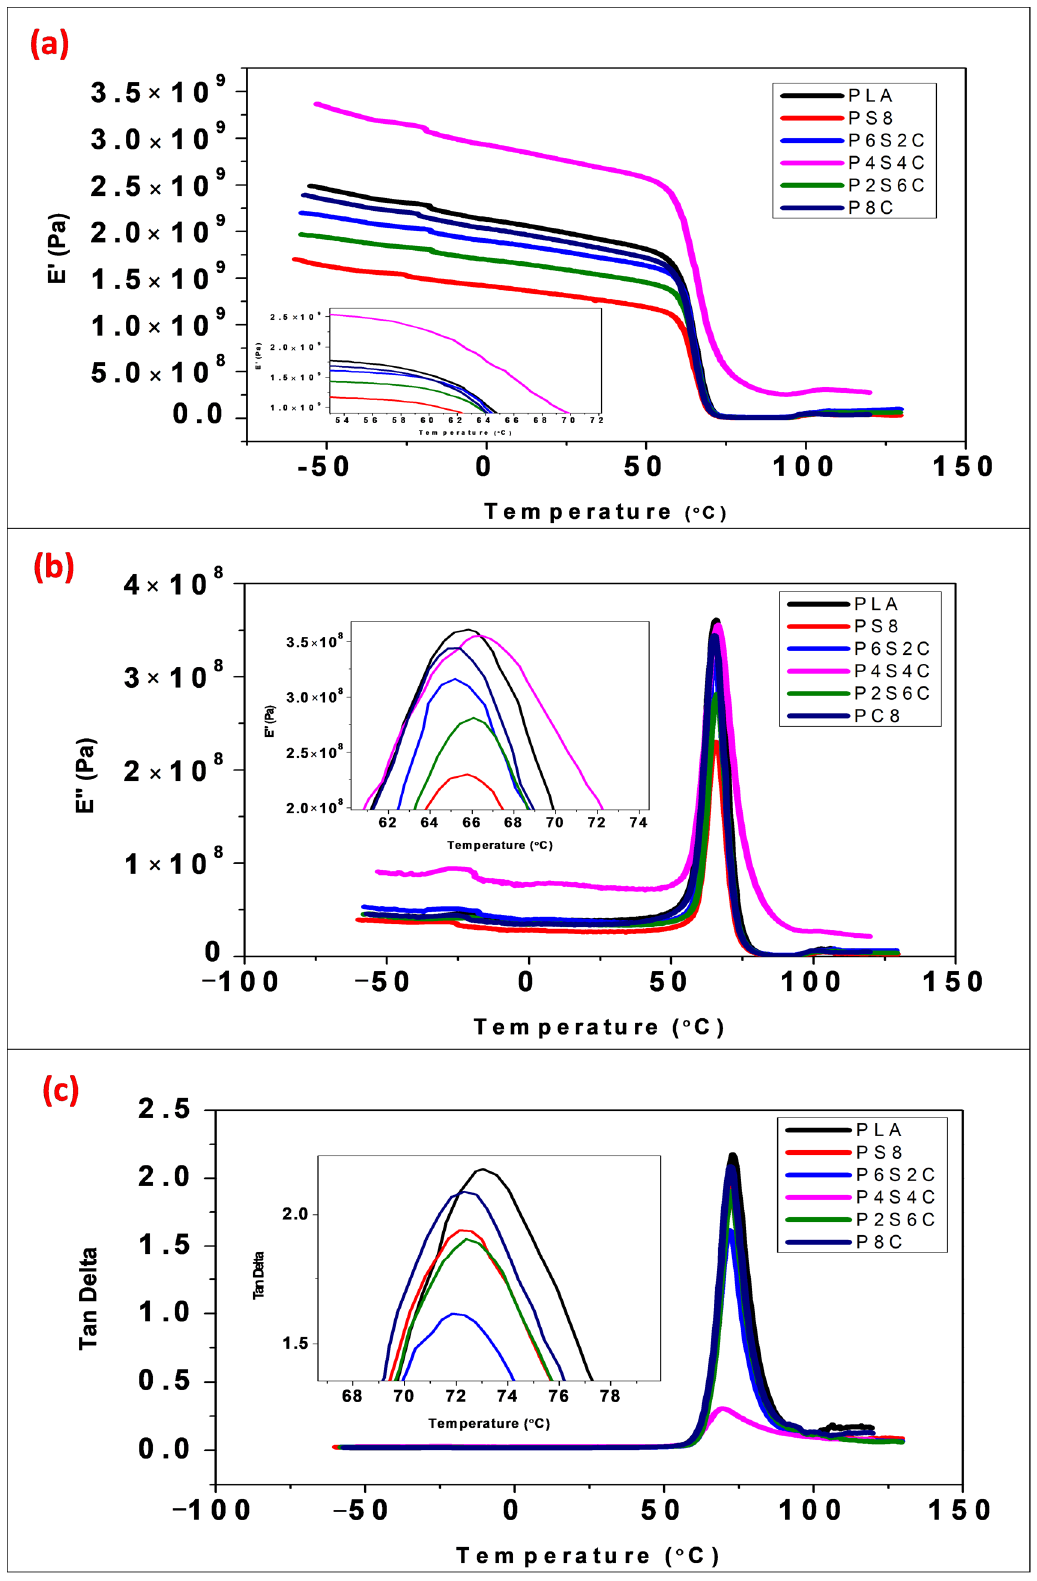
Figure 2. DMA curves at 0.1 Hz of the neat PLA and biocomposite composites ( a ) storage modulus (E ′ ); ( b ) loss modulus (E ″ ), and ( c ) loss factor (tan δ ). The storage modulus of the biocomposite (E ′ ) lowers progressively with an increase in temperature and more significantly as the biocomposite enters the glass transition area